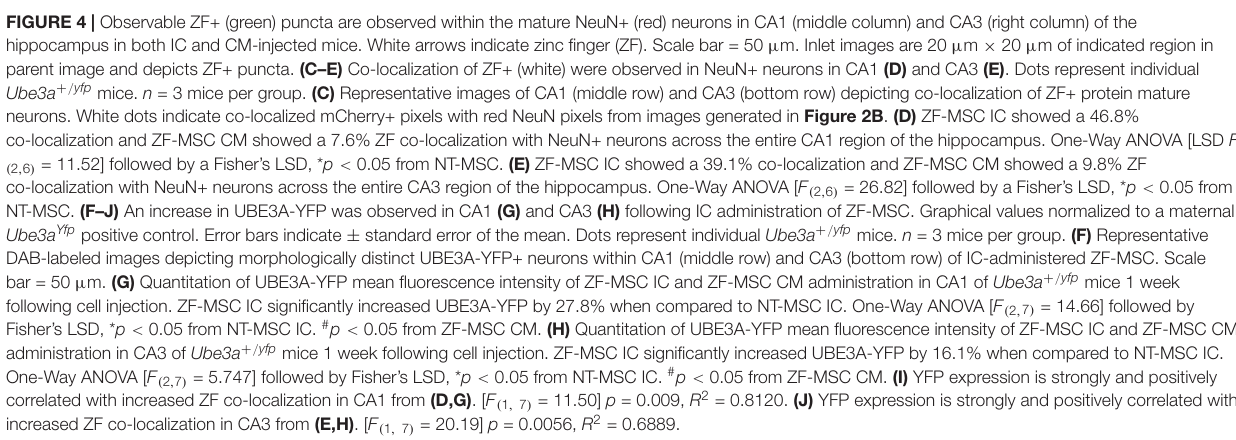
FIGURE 4 | Observable ZF+ (green) puncta are observed within the mature NeuN+ (red) neurons in CA1 (middle column) and CA3 (right column) of the hippocampus in both IC and CM-injected mice. White arrows indicate zinc finger (ZF). Scale bar = 50 µ m. Inlet images are 20 µ m × 20 µ m of indicated region in parent image and depicts ZF+ puncta. (C–E) Co-localization of ZF+ (white) were observed in NeuN+ neurons in CA1 (D) and CA3 (E) . Dots represent individual Ube3a + / yfp mice. n = 3 mice per group. (C) Representative images of CA1 (middle row) and CA3 (bottom row) depicting co-localization of ZF+ protein mature neurons. White dots indicate co-localized mCherry+ pixels with red NeuN pixels from images generated in Figure 2B . (D) ZF-MSC IC showed a 46.8% co-localization and ZF-MSC CM showed a 7.6% ZF co-localization with NeuN+ neurons across the entire CA1 region of the hippocampus. One-Way ANOVA [LSD F ( 2 , 6 ) = 11.52] followed by a Fisher’s LSD, * p < 0.05 from NT-MSC. (E) ZF-MSC IC showed a 39.1% co-localization and ZF-MSC CM showed a 9.8% ZF co-localization with NeuN+ neurons across the entire CA3 region of the hippocampus. One-Way ANOVA [ F ( 2 , 6 ) = 26.82] followed by a Fisher’s LSD, * p < 0.05 from NT-MSC. (F–J) An increase in UBE3A-YFP was observed in CA1 (G) and CA3 (H) following IC administration of ZF-MSC. Graphical values normalized to a maternal Ube3a Yfp positive control. Error bars indicate ± standard error of the mean. Dots represent individual Ube3a + / yfp mice. n = 3 mice per group. (F) Representative DAB-labeled images depicting morphologically distinct UBE3A-YFP+ neurons within CA1 (middle row) and CA3 (bottom row) of IC-administered ZF-MSC. Scale bar = 50 µ m. (G) Quantitation of UBE3A-YFP mean fluorescence intensity of ZF-MSC IC and ZF-MSC CM administration in CA1 of Ube3a + / yfp mice 1 week following cell injection. ZF-MSC IC significantly increased UBE3A-YFP by 27.8% when compared to NT-MSC IC. One-Way ANOVA [ F ( 2 , 7 ) = 14.66] followed by Fisher’s LSD, * p < 0.05 from NT-MSC IC. # p < 0.05 from ZF-MSC CM. (H) Quantitation of UBE3A-YFP mean fluorescence intensity of ZF-MSC IC and ZF-MSC CM administration in CA3 of Ube3a + / yfp mice 1 week following cell injection. ZF-MSC IC significantly increased UBE3A-YFP by 16.1% when compared to NT-MSC IC. One-Way ANOVA [ F ( 2 , 7 ) = 5.747] followed by Fisher’s LSD, * p < 0.05 from NT-MSC IC. # p < 0.05 from ZF-MSC CM. (I) YFP expression is strongly and